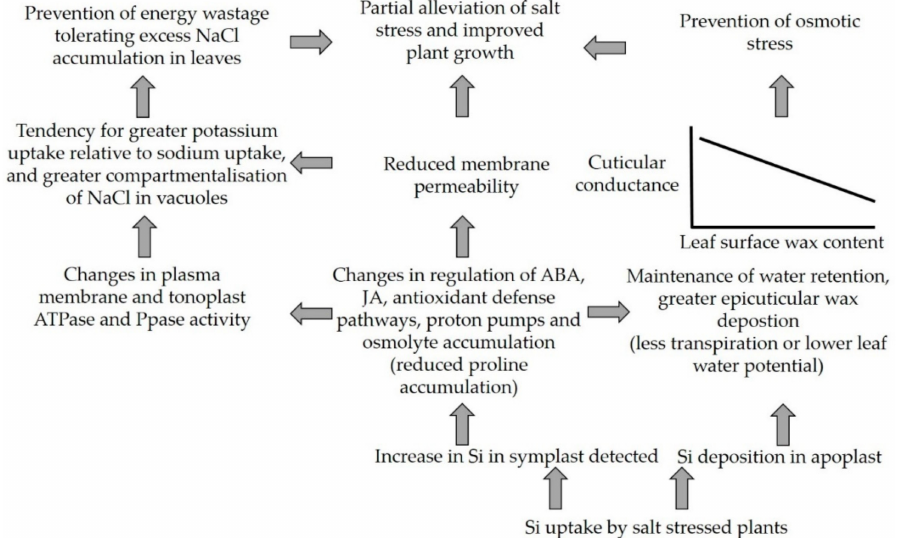
Figure 5. Schematic diagram indicating the beneficial responses that occur in salt stressed plants when they are supplied supplemental silicon. Abscisic acid (ABA); jasmonic acid (JA), ATPase (enzymes that catalyze the decomposition of ATP into ADP and a free phosphate ion or the inverse reaction), Ppase (proton-pumping pyrophosphatase); schematic adapted from Liang et al. 2015 [46] and the representation of the relationship between cuticular conductance and leaf wax surface content is adapted from Agarie et al., 1998